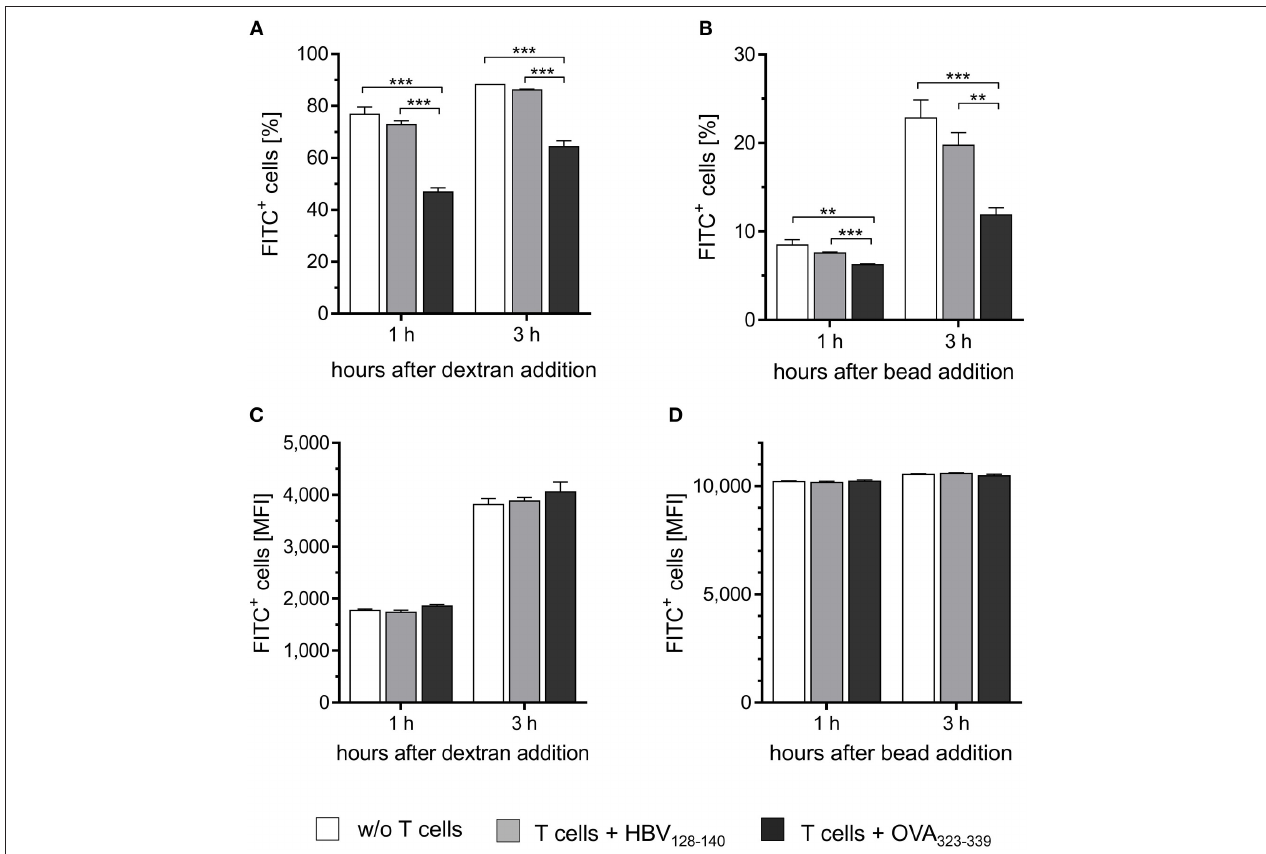
FIGURE 3 | CD4 + T cells instruct M2-like PECs to acquire M1-like function. PECs were cultured with IL-4 for 24h to induce M2 polarization. Subsequently, M2-like PECs were loaded with 1 µ g/ml IA b restricted OVA-specific peptide or with irrelevant control peptide and co-cultured with an OVA-specific CD4 + Th1 cell line for 24h. Co-cultured PECs were then incubated with FITC-dextran (A,C) or with fluorescent latex beads (B,D) for different time periods (1 and 3h) to monitor pinocytic and phagocytic capacity, respectively. Co-culture of M2 polarized PECs with CD4 + T h1 cells in the presence of OVA-specific peptide significantly decreased both, phagocytic as well as pinocytic activity compared to the control groups (A,B) , whereas median fluorescence intensities did not differ between the groups (C,D) . Significance was determined using One-way ANOVA with post-hoc Tukey test (95% CI, ** p < 0.01, *** p ≤ 0.001). Gating strategy: living cells → single cells (FSC-A vs. FSC-H) → FITC vs. FSC-H. Error bars represent SD of technical triplicates.